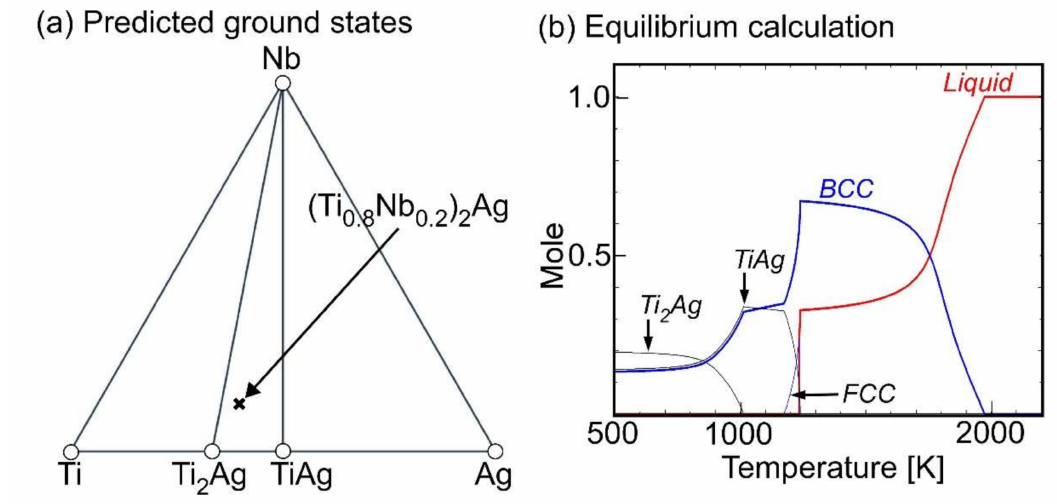
Figure 3. ( a ) Predicted ground states in ternary Ti–Ag–Nb alloy system constructed by the Materials Project, and ( b ) the equilibrium calculation in Ti 53.4 Ag 33.3 Nb 13.3